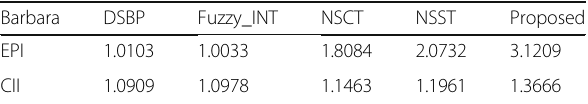
Table 4 Objective evaluation parameters for the SAR image